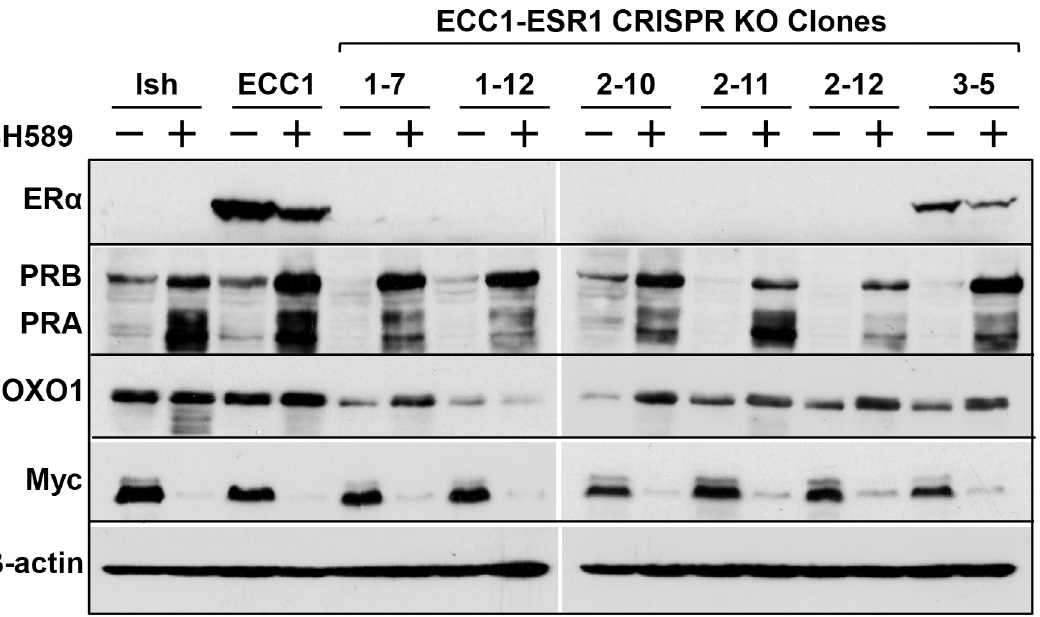
Fig 1. HDAC inhibitor (panobinostat, LBH589) upregulates PR expression and downregulates Myc in ER α knockout endometrial cancer cells lines. Using CRISPR-Cas9 technology, ER α was silenced at the genomic level in ECC1 cells. Ishikawa, parental ECC1 cells and individual ESR1 KO ECC1 clones were treated with 20 nM LBH589 for 24 hr. Expression of ER α , PR, FOXO1, and Myc were evaluated by Western blotting. β -actin serves as a loading control.